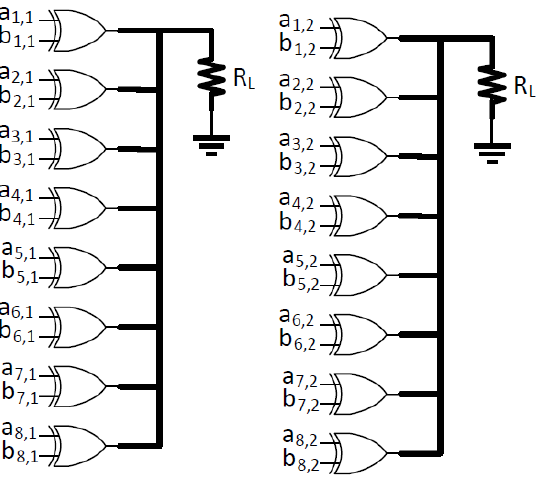
Figure 11. 8-bit two-share XOR with a i , j and b i , j for Share 1 and Share 2 , where i is the input bit, j is the share number, and R L is 100 Ω